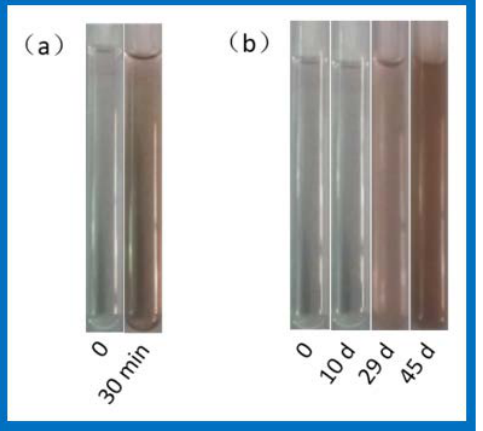
Figure 5. Comparison of light stability: ( a ) The color of SD-Ag solution became brown after being exposed to fluorescent light for 30 min; ( b ) the color of PR-(SD-Ag) did not change until day 29, when it became slightly transparent and red, and dark brown after day 45.